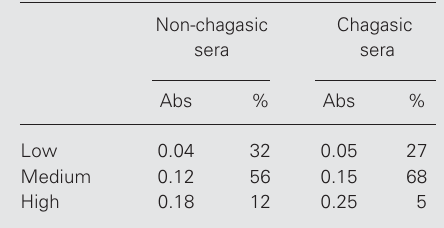
Table 2. Reactivity with HeLa human U small nuclear ribonucleoproteins (UsnRNPs) of sera from patients with non-chagasic and chagasic heart disease.